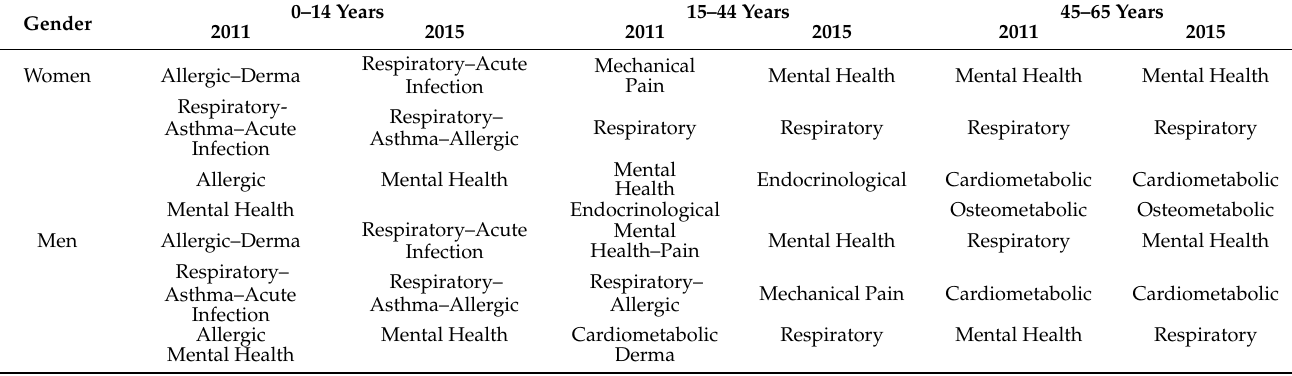
Table 3. Comparison of multimorbidity and polypharmacy patterns identified in each age and sex group in 2011 and